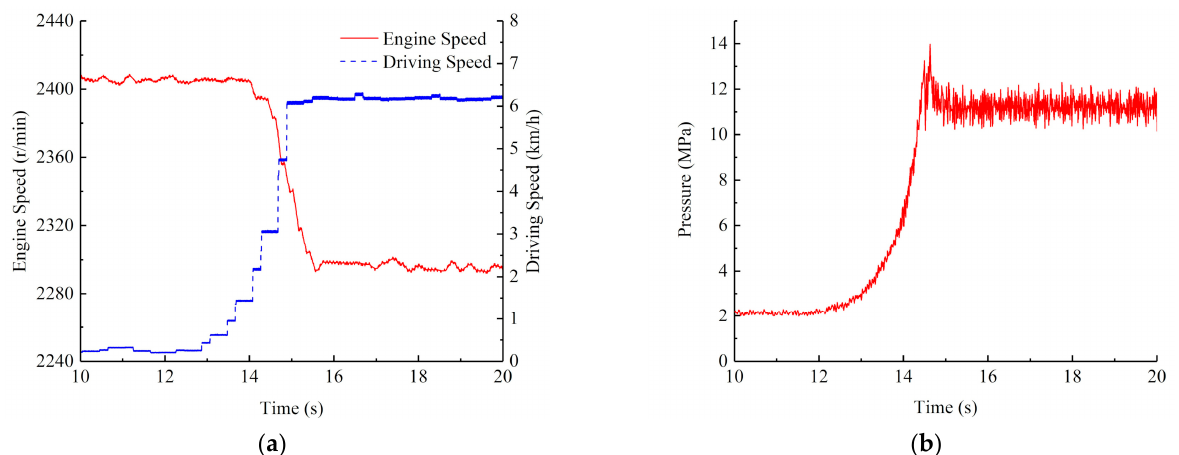
Figure 14. Parameters when starting on slope in Gear II: ( a ) change in the engine speed and driving speed; ( b ) inlet and outlet pressure difference of the hydraulic motor.